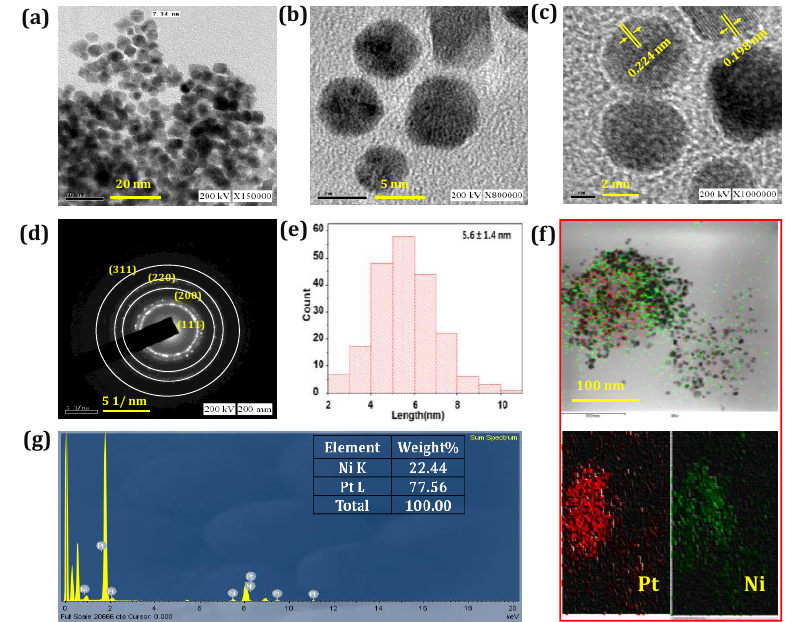
Figure 2. ( a ) TEM image, ( b , c ) HRTEM images, ( d ) selected area electron diffraction (SAED) pattern, ( e ) particle size distribution, ( f ) EDX mapping images, ( g ) EDX spectrum of PtNi NPs (insert: elemental weight percentage).